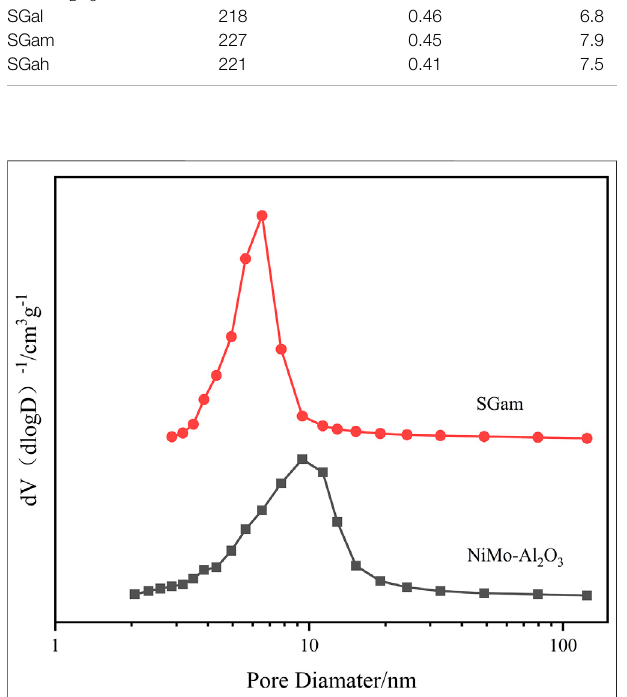
FIGURE 2 | Pore diameter distribution of impregnated Ga-modi fi ed Ni – Mo/Al 2 O 3